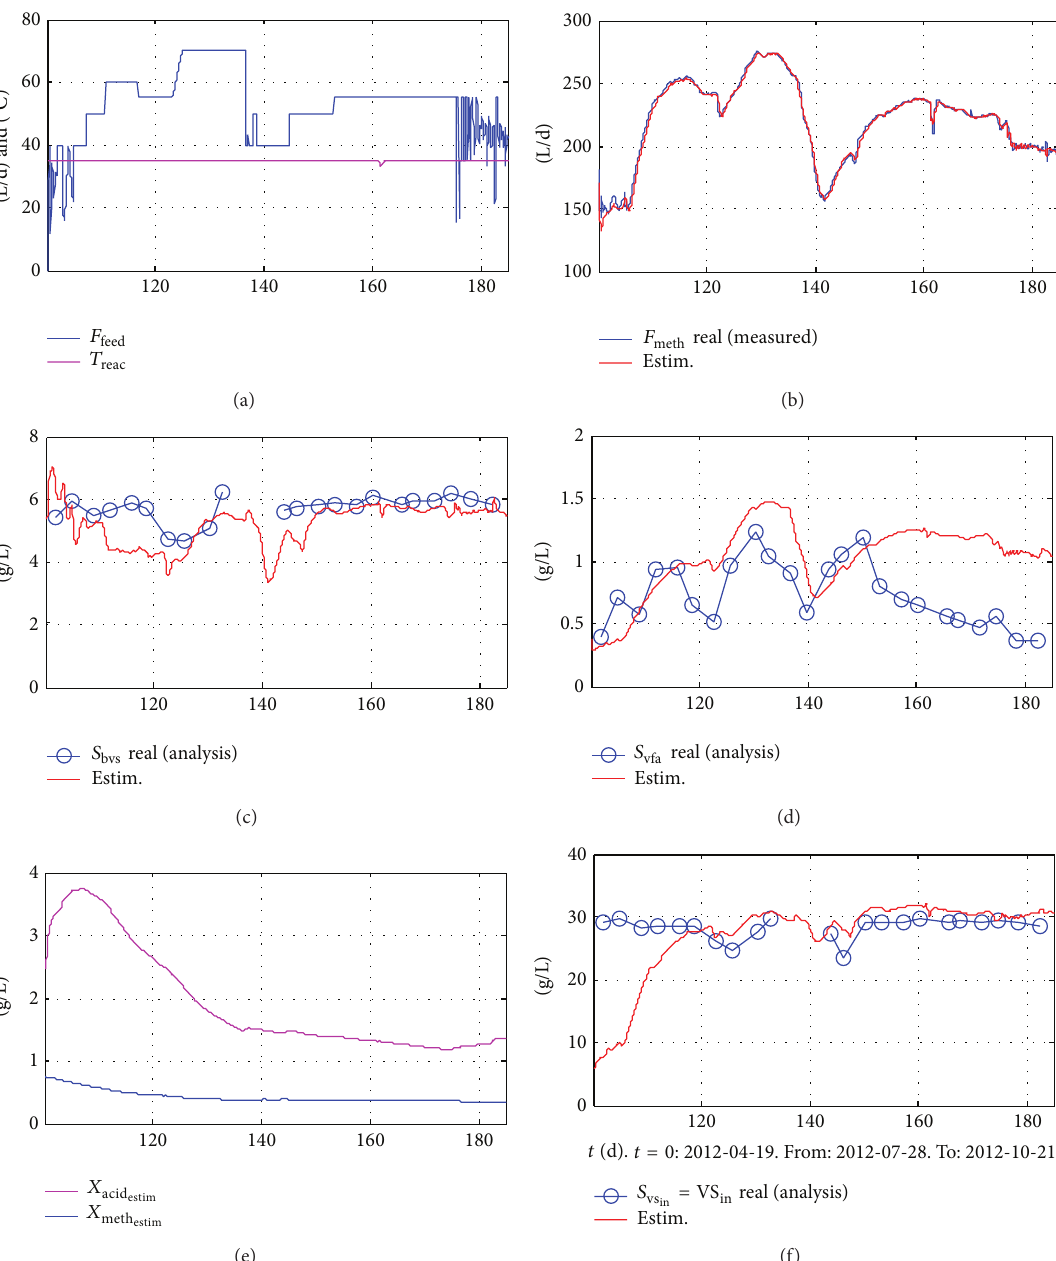
: 0.62 g/L; 𝑆 : 0.32 g/L; bvs vfa